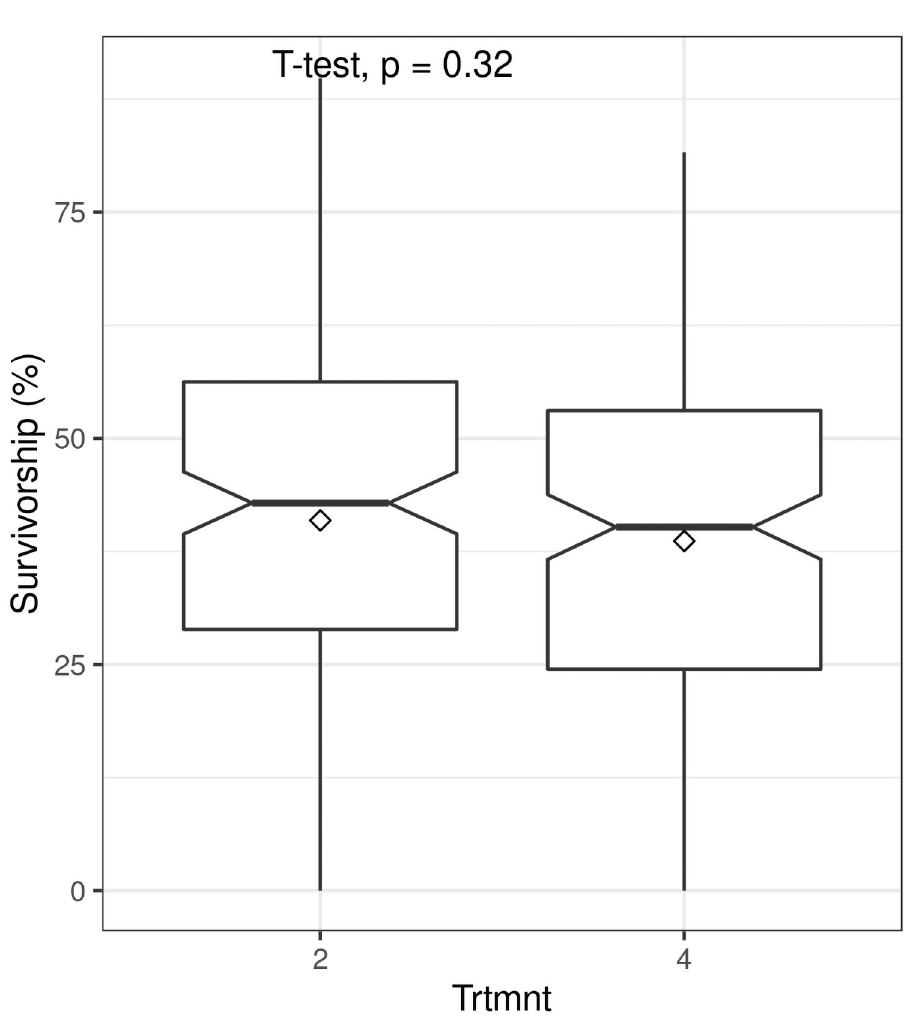
Fig 5. Boxplots showing the effect on survivorship of root hormone application at planting (Trtmnt 2 = no hormone, Trtmnt 4 = hormone application; see Tables 1 and 2 for details) of spekboom ( Portulacaria afra ) truncheons of 22.5 mm diameter planted at 1 m intervals. Within-box horizontal lines depict median values and the diamonds depict mean values.